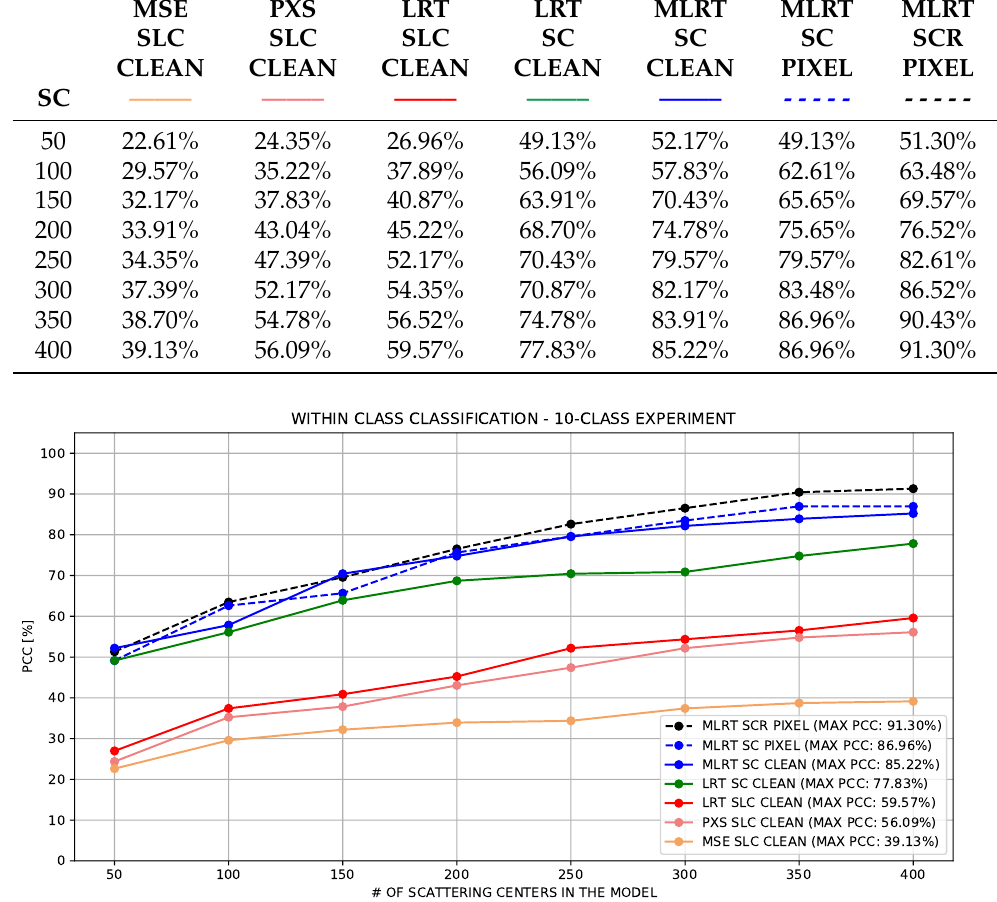
Figure 13. Standard Operating Condition—Classification resulting from different